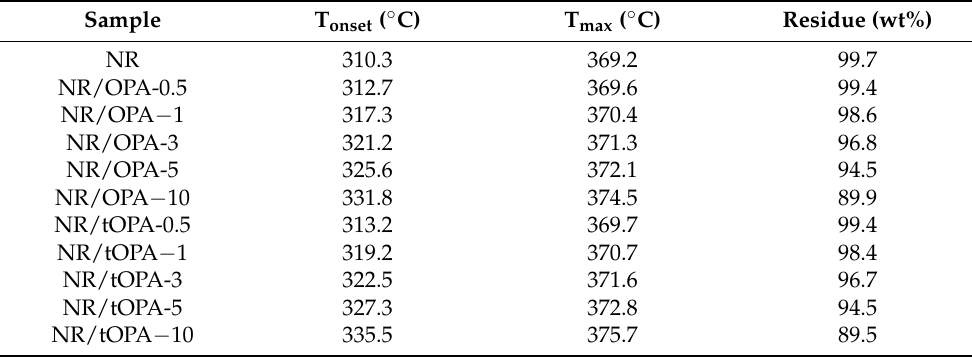
Figure 14. ( a ) TGA and ( b ) DTG curves of unfilled NR and NR/OPA and NR/tOPA at various filler loadings. Table 9. TGA data of NR containing OPA and tOPA at different